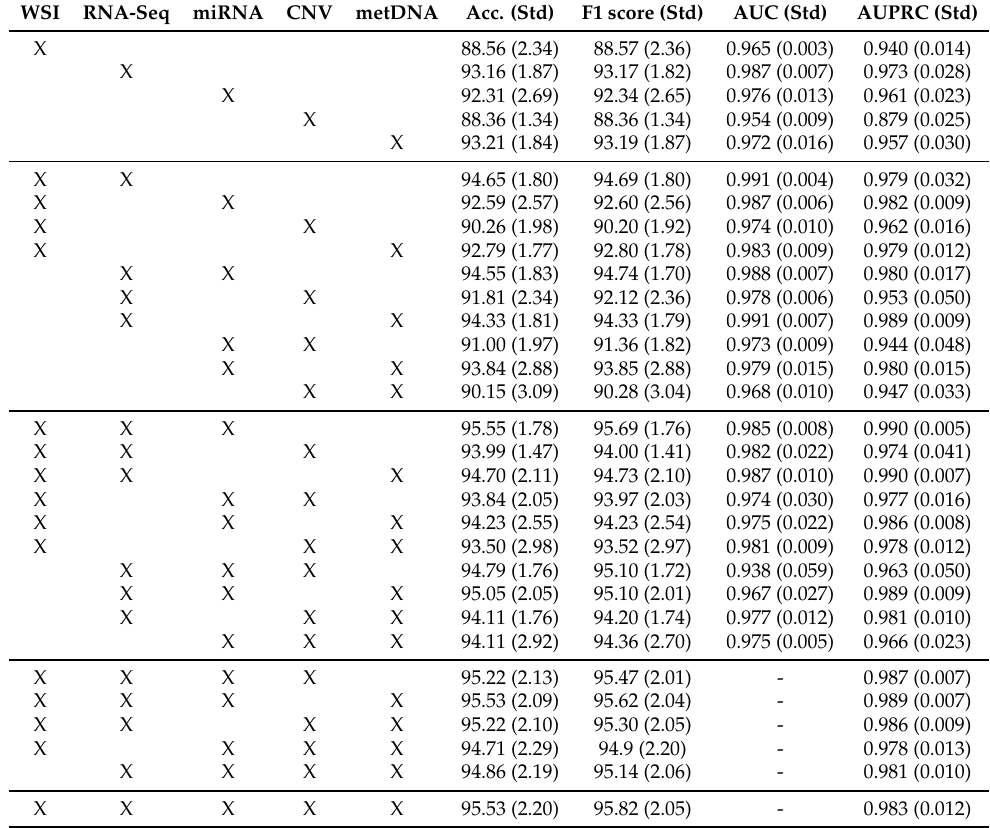
Table 4. Results obtained in the 10-fold CV by each single modality and multimodal fusion of the modalities in their common samples (see Supplementary Material Tables S1–S3). For the case of four- and five-modality fusion, AUC is omitted given the low number of control samples. The X marks the modalities that are used in each